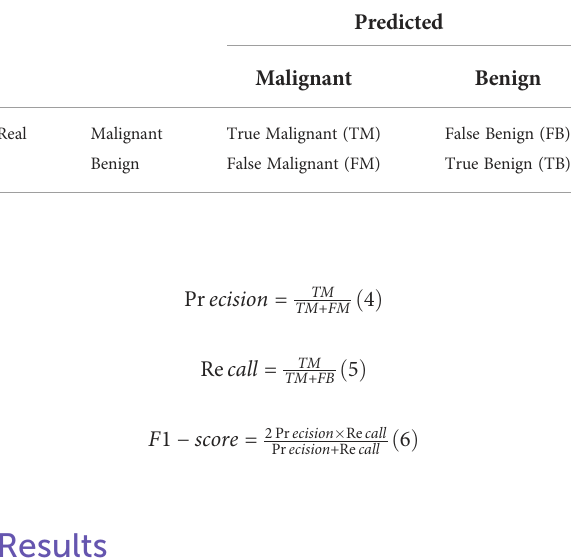
TABLE 2 Confusion matrix. TABLE 4 Metrics and results of meta model evaluation of test data.